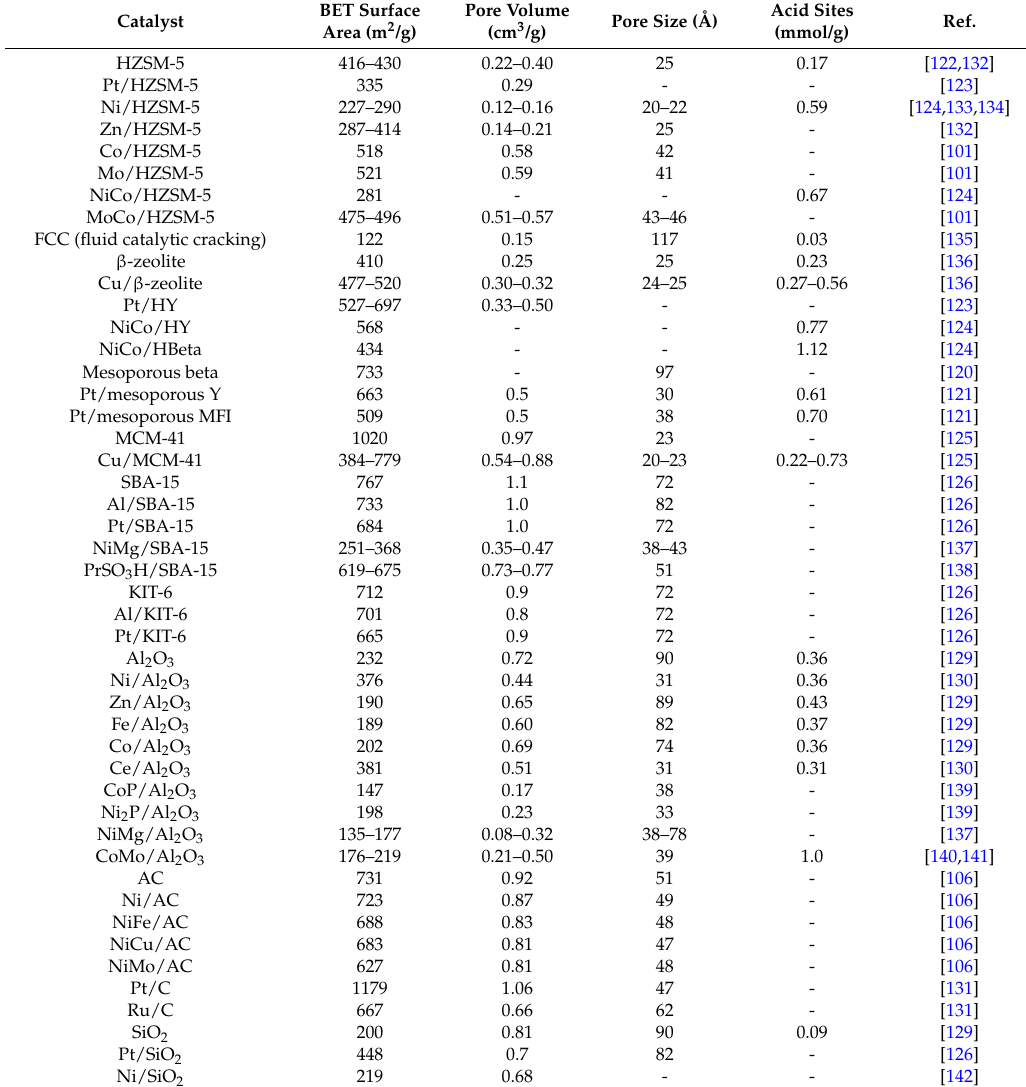
Table 10. The properties of catalysts used in bio-oil upgrading to